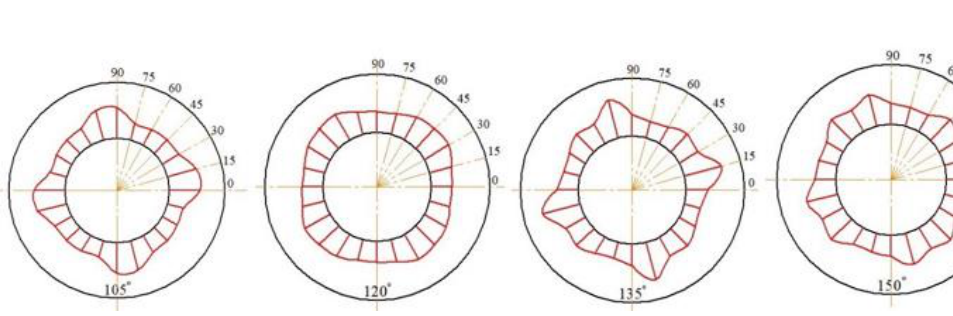
Figure 10b: Graphical representation of circumferential variation of stiffness for 4 grooves ISSFD rings